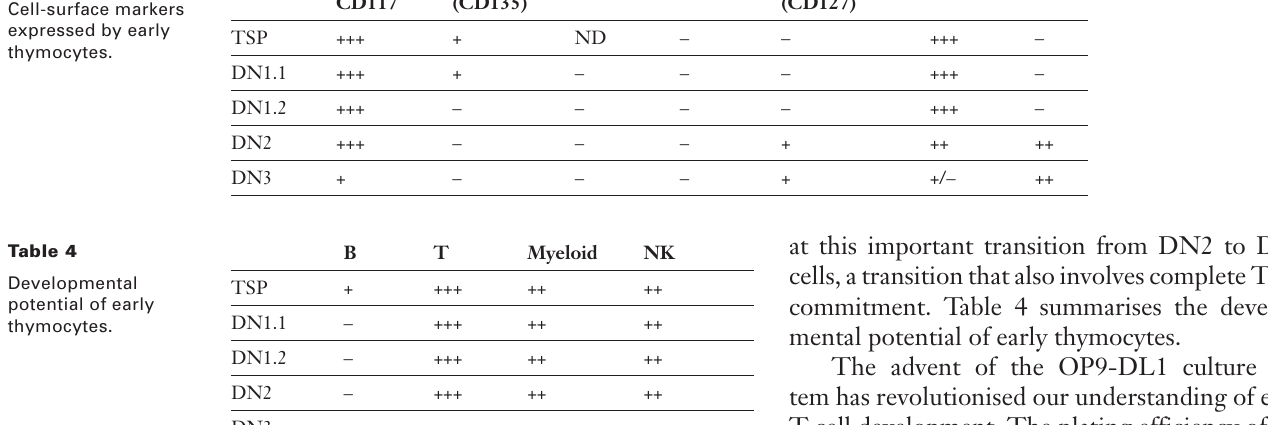
Cell-surface markers expressed by early thymocytes.